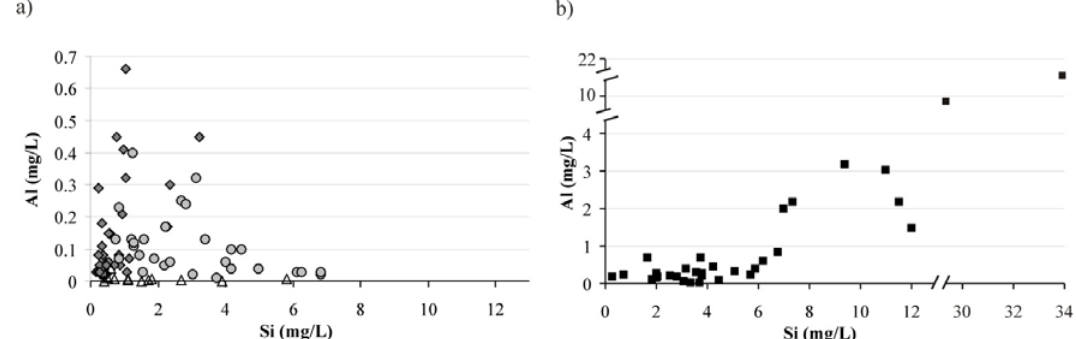
Figure 9. Relationships Al vs. Si for lakes, rivers, waters of stone pits and exploration trenches ( a ) and for waters of active layer ( b ). Symbols as in Figure 5.